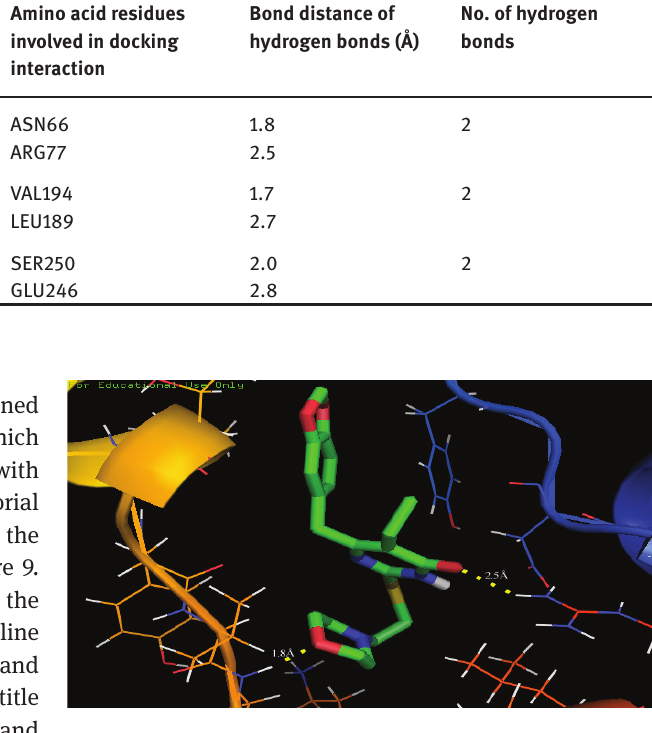
Table 4 : Molecular docking results with different target proteins. Target protein ID